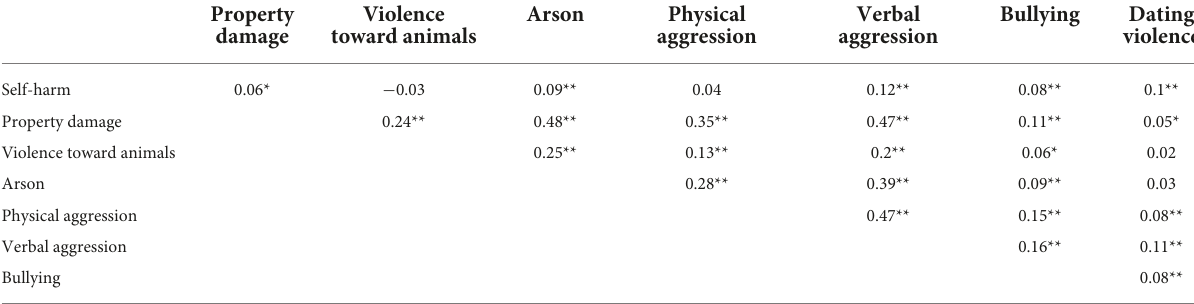
TABLE 1 Correlation matrix between all harmful behaviours examined in the study.